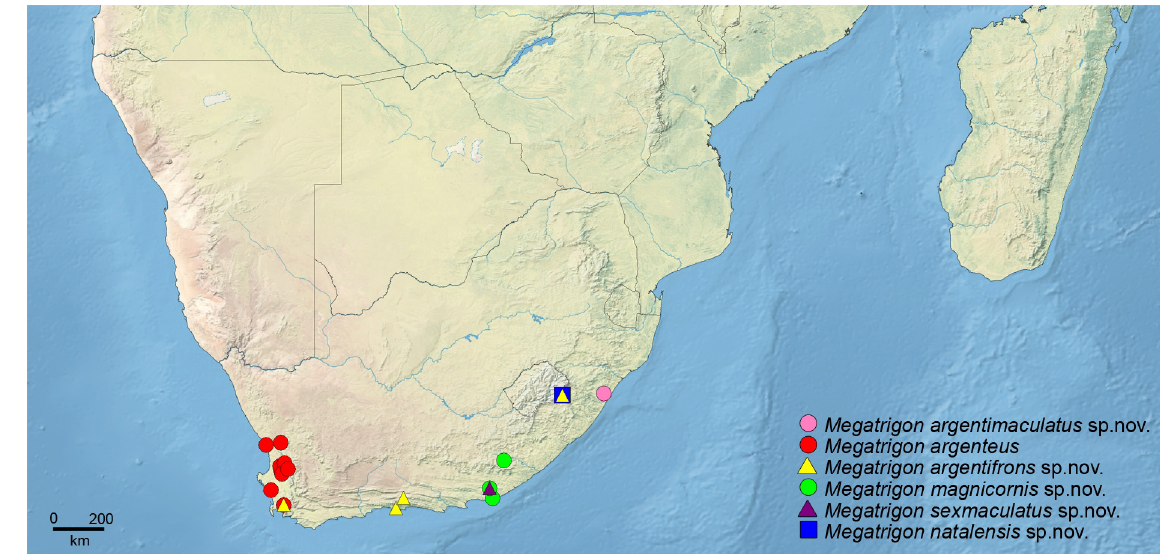
Fig. 15. Megatrigon argenteus species group (subgroup 1),